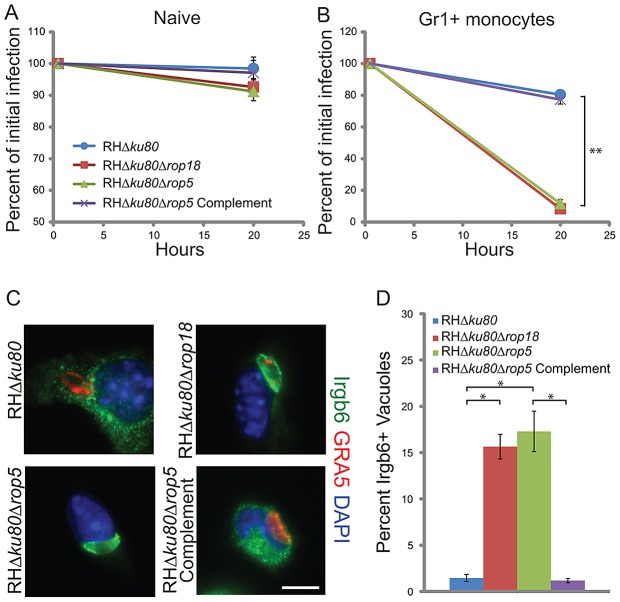
ROP5 and ROP18 are required for avoidance of clearance and IRG recruitment.
In vitro clearance of parasites in naïve peritoneal macrophages (A) or Gr1+ inflammatory monocytes (B) was measured by immunofluorescence microscopy. Cells were stained at 0.5 and 20 h post infection for host cell surface markers (see methods) and the parasite surface marker SAG1. Infection rates at 20 h post infection were normalized to initial infection rates. Means ± S.E.M., n = 3 samples each, from 3 combined experiments. Student's t test, **P<0.0005. (C) Immunofluorescence localization of Irgb6 on the parasitophorous vacuole membrane in Gr1+ inflammatory monocytes infected for 0.5 h in vitro. The vacuole membrane was visualized by staining with mAb Tg 17-113 for GRA5 (secondary: Alexa Fluor 594, red). Irgb6 was visualized with rabbit anti-Irgb6 (secondary: Alexa Fluor 488, green). Scale = 5 microns. (D) Quantification of Irgb6 localization to the vacuolar membrane in Gr1+ monocytes. Mean ± SEM, n = 3 samples each, from 3 combined experiments. Student's t test, *P<0.005.